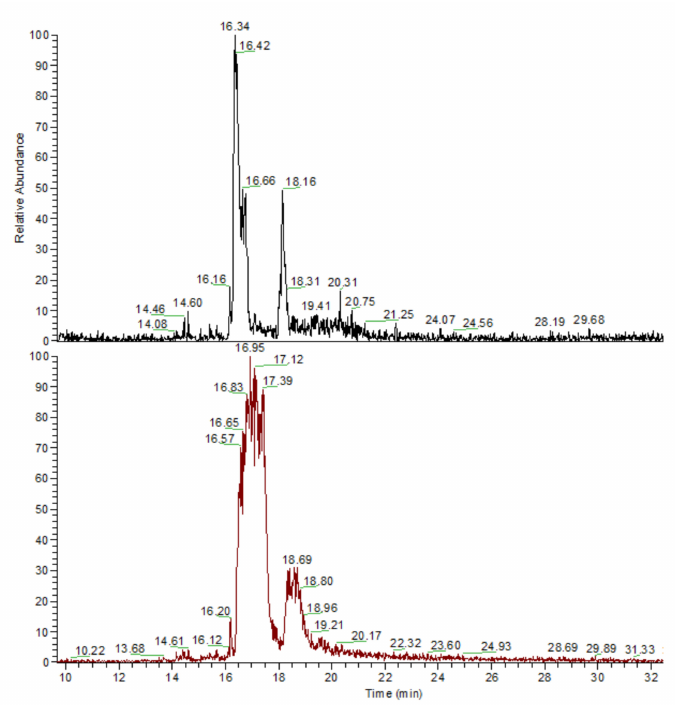
Figure 5. Selected ion ( m/z 127) chromatograms: 40 ◦ C ( top ), 70 ◦ C ( bottom ).